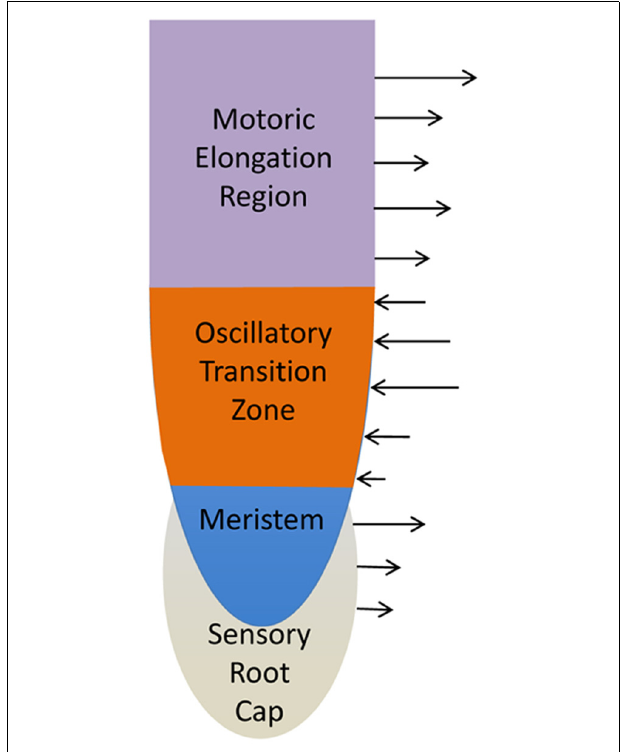
FIGURE 4 | Schematic views of cellular root apex zones and their electric fields. Sensory root cap is enclosing the meristem with dividing cells.These two most apical zones are characterized by the outward electric current (Collings etal., 1992; Baluška and Mancuso, 2013a). Adjacent transition zone is characterized with two inversions of the electric current pattern at the root apex.The apical border of the transition zone accomplishes the outward–inward switch whereas the basal border the inward–outward switch (Collings etal., 1992; Baluška and Mancuso, 2013a). The elongation region is characterized again by the outward electric current. High root synaptic activities at the transition zone are linked with the prominent inward electric